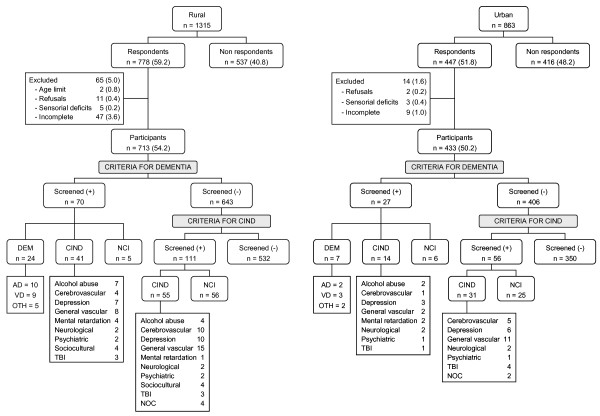
Sample, participants and cognitive impairment classification. General vascular: with at least one vascular risk factor (high blood pressure, cardiac disease, diabetes and dyslipidemia); TBI: traumatic brain injury; NOC: no other condition